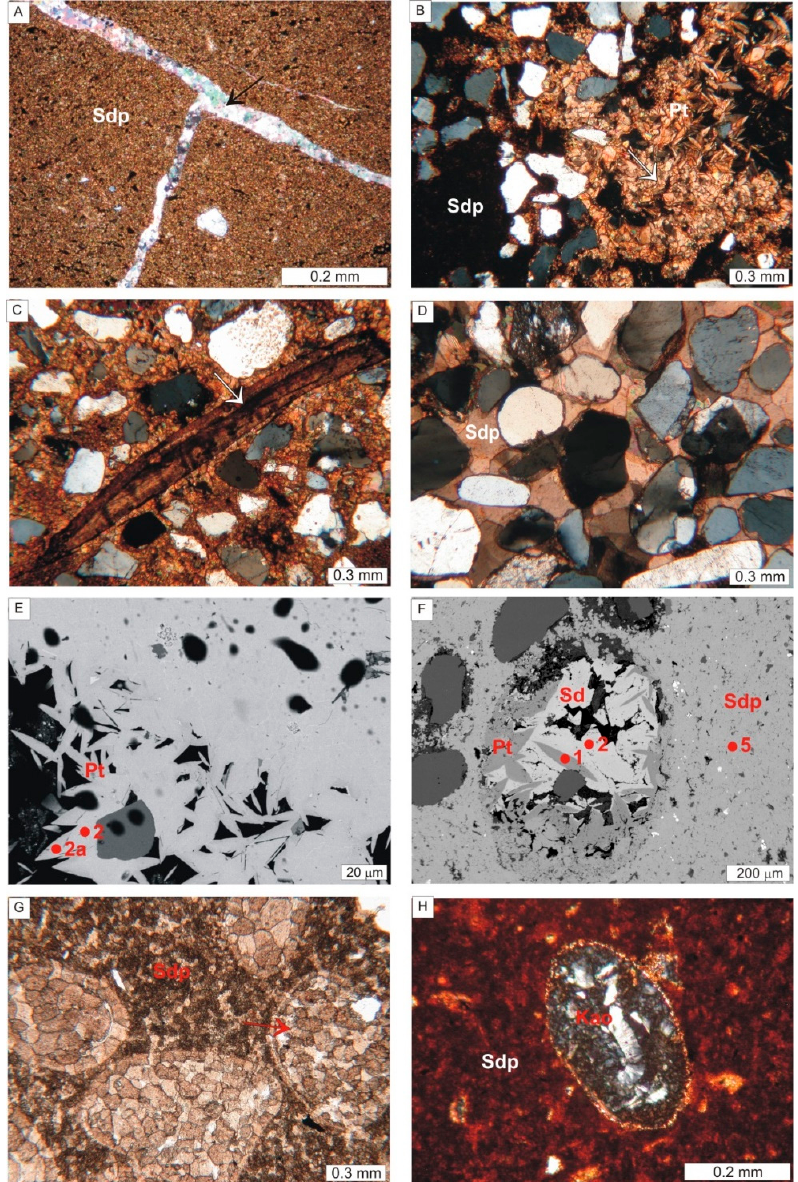
Figure 3. Photomicrographs of siderite rocks in polarizing microscope (PL) and scanning electron microscope (BSE). ( A ) Clayey siderite built of a sideroplesite micrite (Sdp) cut by a calcite vein (arrow); Mołdawa borehole, depth 304.5 m, PL—crossed nicols. ( B ) Sideroplesite micrite (Sdp), microsparite sideroplesite (arrow), and sparite rhomboedrons of pistomesite (Pt) in clayey-sandy siderite; Omi˛ecin XI/3, depth 132.2 m, PL—crossed nicols. ( C ) Clayey-sandy microsparite siderite with fragment of a brachiopod shell (arrow); Gutwin borehole, depth 176.3 m, PL—crossed nicols. ( D ) Clayey-sandy siderite with spary sideroplesite cement (Sdp); Omi˛ecin XI/3 borehole, depth 225.0 m, PL—crossed nicols. ( E ) Rhomboedrons of pistomesite (Pt) with a weakly visible zonal structure in a cement of clayey-sandy siderite; points of chemical analyses (EDS) in siderite (Table S2); Omi˛ecin XI/3 borehole, depth 132.2 m, BSE image. ( F ) Siderite (Sd)–pistomesite (Pt) ooid in clayey-sandy siderite built of a sideroplesite micrite (Sdp); points of a chemical analyses (EDS) in siderite (Table S2); W ˛aglany k/Opoczna borehole, depth 597.2 m, BSE image. ( G ) Sideroplesite ooids (arrow) in clayey-sandy siderite built of a sideroplesite microsparite (Sdp); W ˛aglany k/Opoczna borehole, depth 395.2 m, PL—one nicol. ( H ) Kaolinite ooid (Kao) in clayey siderite built of a sideroplesite micrite (Sdp); Justyn ó w PIG 1 borehole, depth 20.3 m, PL—crossed